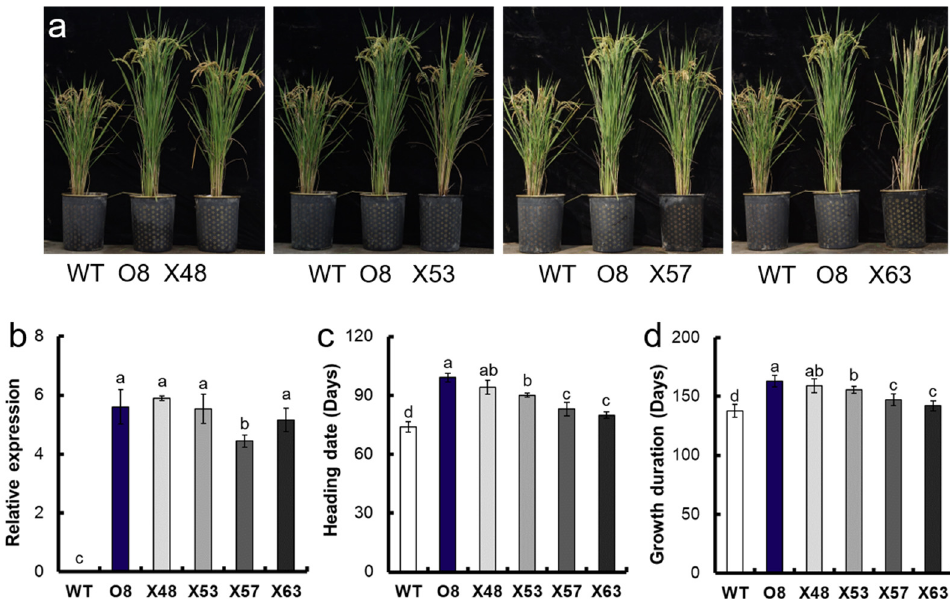
Figure 2. Growth duration and grain yield of EMS mutants in M4 and M5 generations. Growth duration of EMS mutants in ( a ) M4 and ( b ) M5 generations. Error bars: SE ( n = 10 plants). Grain yield of EMS mutants in ( c ) M4 and ( d ) M5 generations. Error bars: SE ( n = 3).